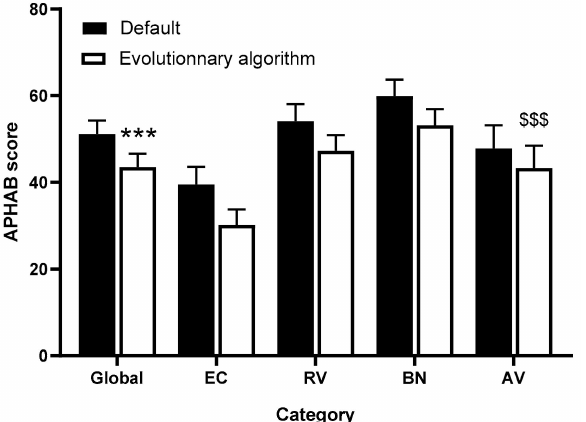
Figure 6. APHAB questionnaire scores with default and evolutionary algorithm settings. Values are expressed as mean ± standard error of mean. *** p < 0.001 versus default for the global score, Wilcoxon signed-rank test. $$$ p < 0.001 for the effect of setting, and p < 0.01 for the effect of APHAB ranges, no significant interaction, 2-way ANOVA. EC = ease of communication, RV = reverberation, BN = background noise, AV =